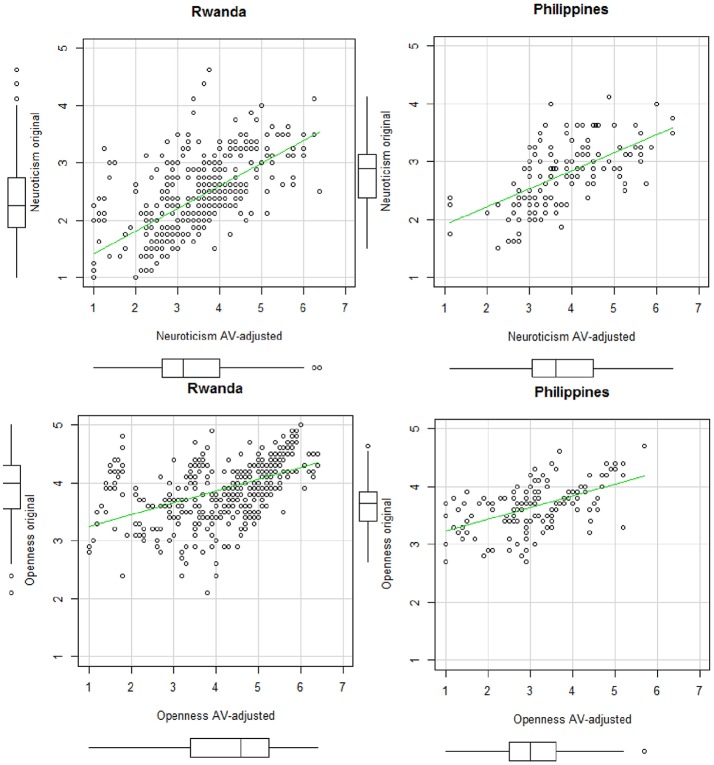
Same as Figure 1.